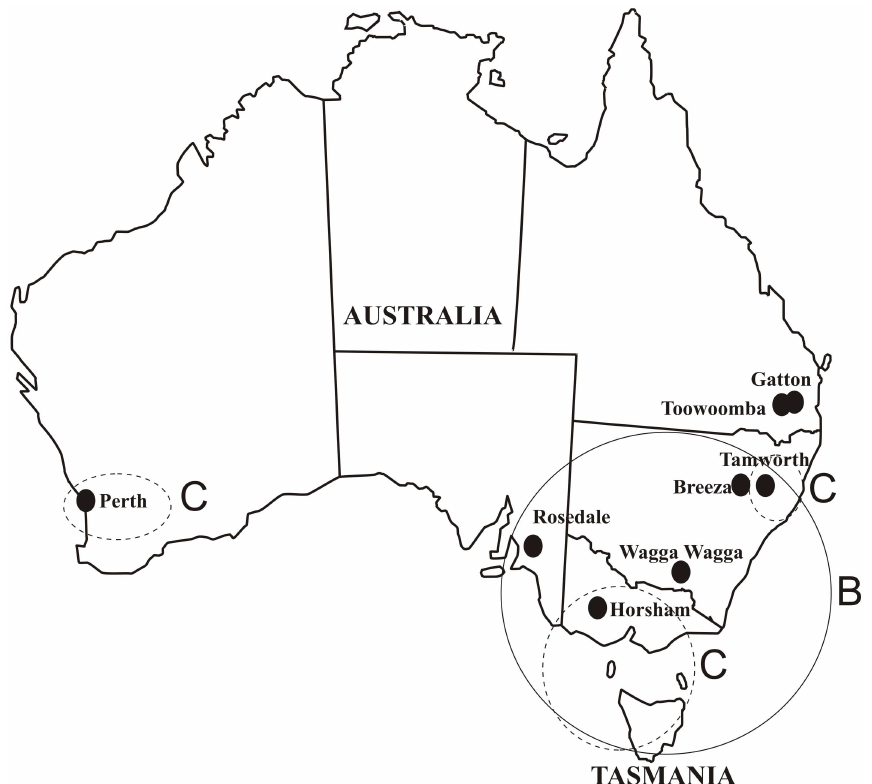
Fig 4. Origin of Australian Blumeria graminis f. sp. hordei isolates. Number of isolates collectedon individual localitiesis as follows: Perth (5), Rosedale(6), Horsham (5), Tasmania(7), Wagga Wagga (9), Tamworth (10), Toowoomba (6), Gatton (2). Since the Australian isolates exhibitlow level of genetic variability, only three distinct groupswere identified(Fig 2). The major haplotypeA) is spread through whole Australia and may represent the oldest Bgh introduction. The haplotypeB) which is highly similar to A) and found only in the south east territories. C) The group with relatively high diversity and similarity to abroad isolatefrom Uruguaywas found only in the costal territories and may represent the latest influx of Bgh isolates into